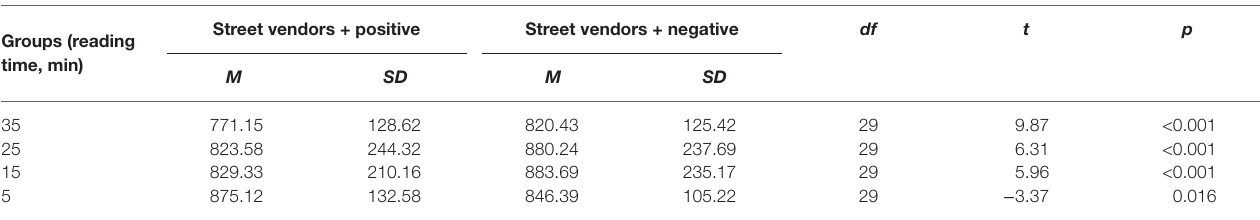
TABLE 3 | Means and SDs of SC-IAT after reading positive and negative posts ( N = 240). Groups (reading time,